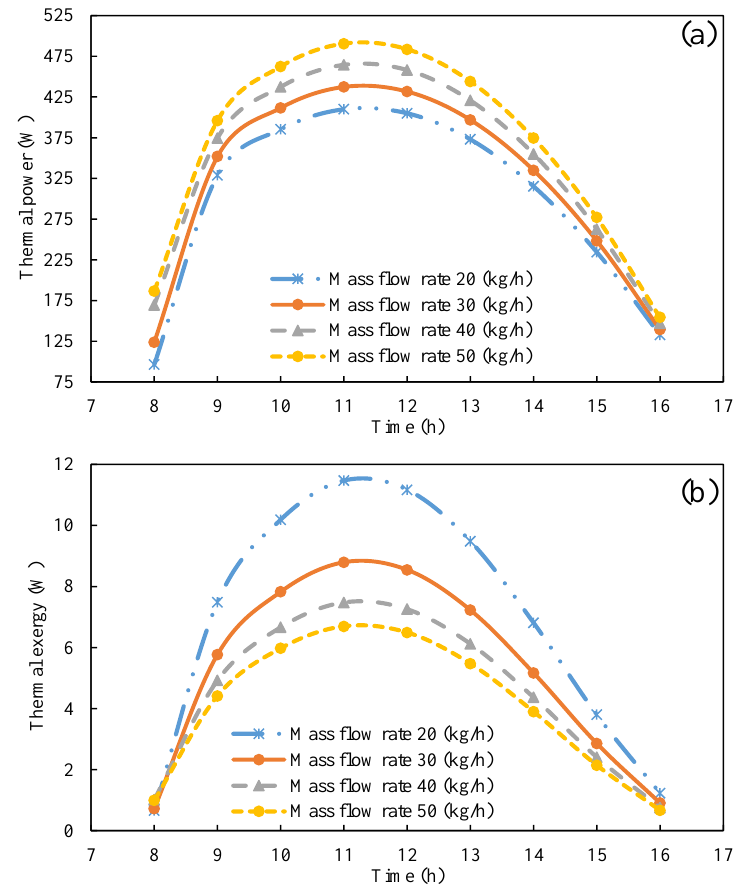
Fig. 8. Temporal variations of the (a) thermal power and (b) rate of thermal exergy at different mass flow rates during a day in